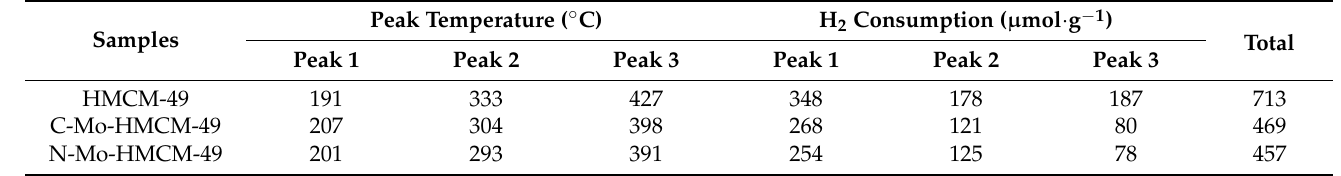
Figure 6. NH 3 -TPD of the catalyst before and after modification. Table 2. The textural properties of HMCM-49, C-Mo-HMCM-49 and